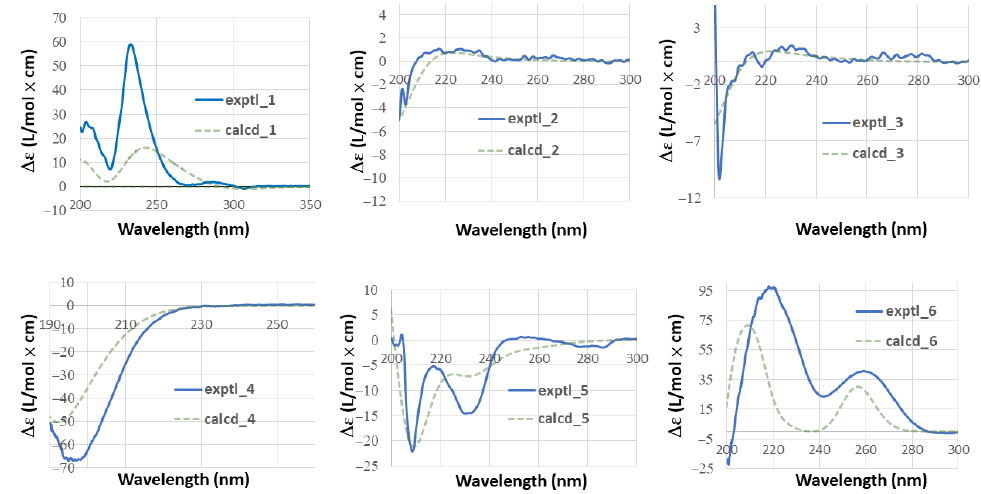
Figure 4. Experimental and calculated ECD spectra of 1 − 6 .